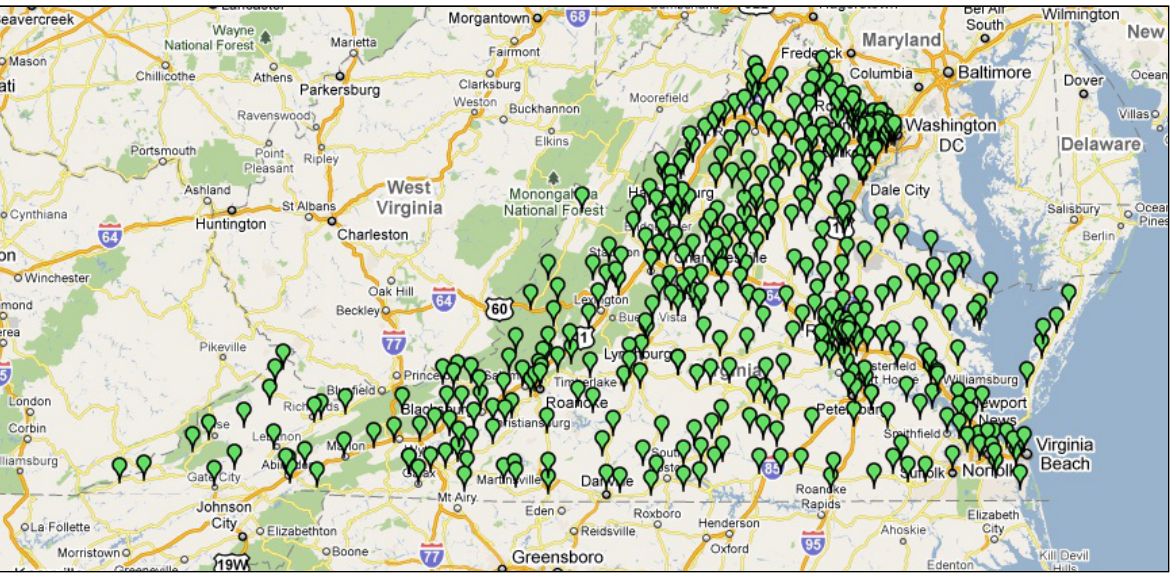
Figure 1. Map of Zip Codes with at Least One Respondent to the Virginia Food System Survey